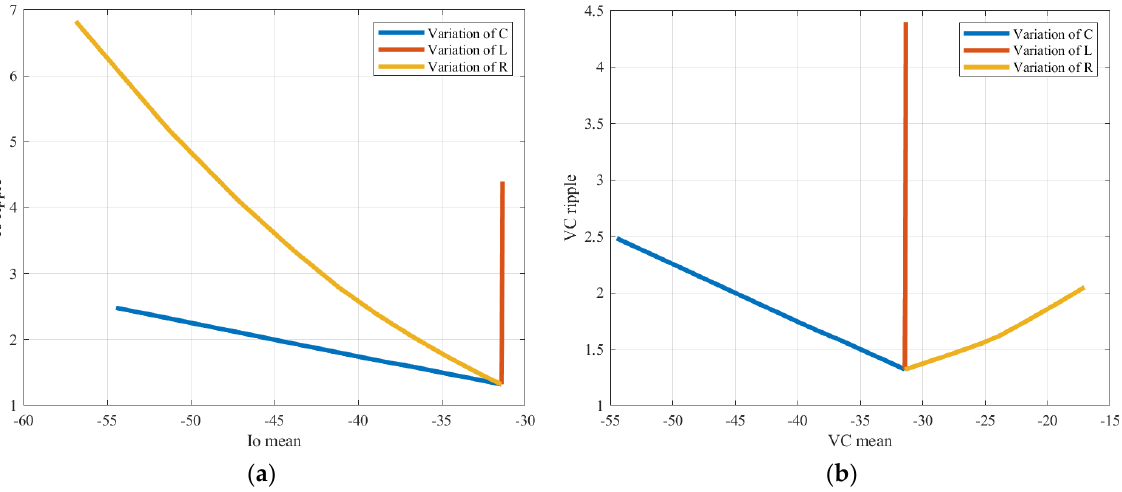
Figure 16. Testability assessment for a buck – boost converter in correspondence of the third topology in DCM: ( a ) output current; ( b ) output voltage.